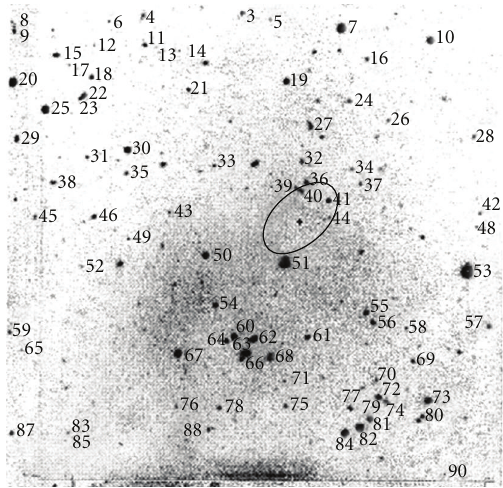
Figure 8: The deep sky objects inside and arround the error box of the OT GRB910219.